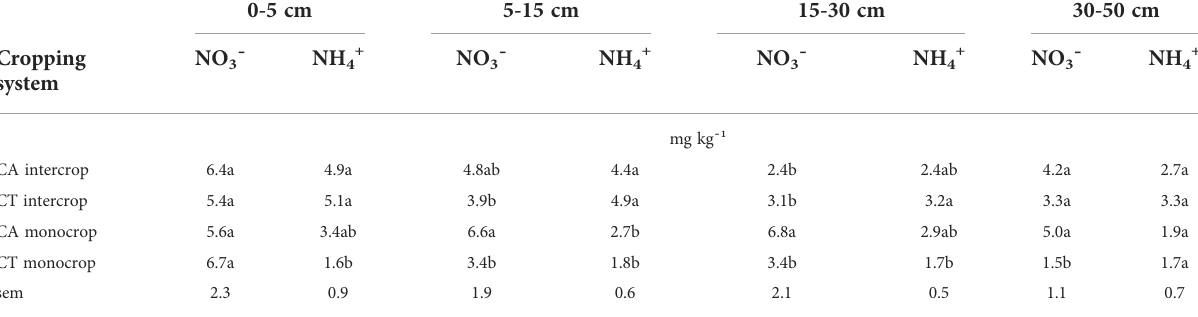
TABLE 1 Soil mineral N and standard error of the mean (sem) across depths and cropping